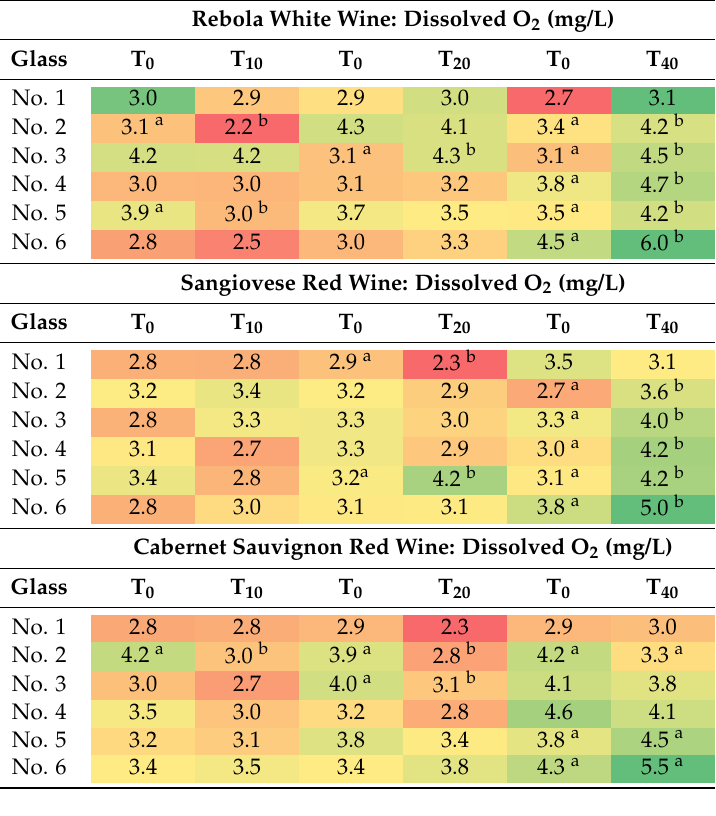
Glass parameters, Table S1: Chemical composition of wines, Figure S2: Experimental online